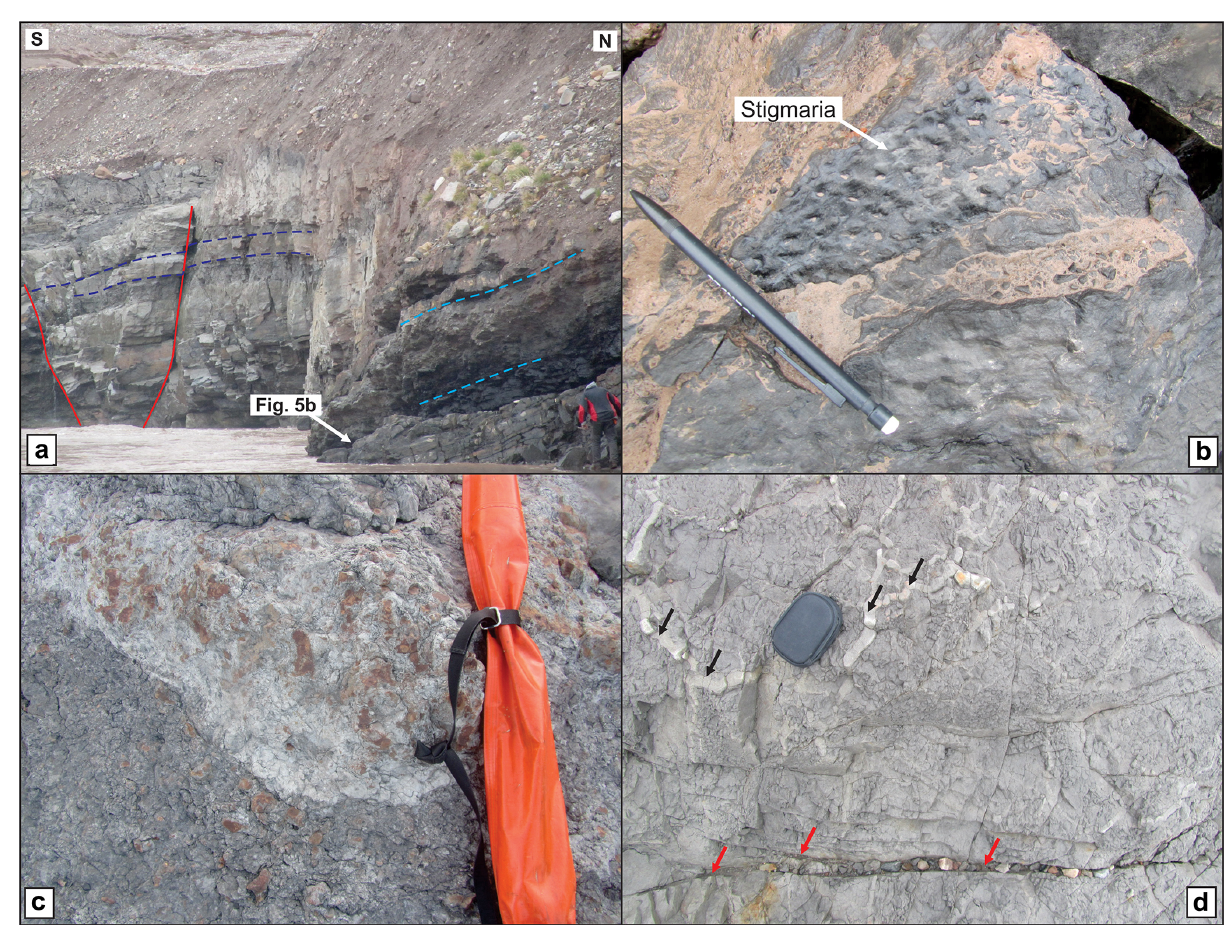
Figure 5. Outcrop photographs showing (a) southwestwardly tilted sedimentary rocks of the Billefjorden Group consisting of interbedded coal-bearing shales and grey sandstone in the lower part (light blue) and interbedded coaly shales, grey sandstone, and grey claystone with iron nodules in the upper part (dark blue). Person for scale in the lower right corner. (b) Stigmaria ficoides in the lower part of the Billefjorden Group succession. Location shown in (a) . (c) Grey claystone with abundant iron nodules in the upper part of the Billefjorden Group succession. Orange rifle cover as scale (approximately 1.20m long). (d) Soil features in grey claystone crosscut by fractures (red arrows) and polygonal fractures (black arrows) in the upper part of the Billefjorden Group succession. Camera cover (15 × 10cm) as scale. Outcrop locations shown in Fig. 4.